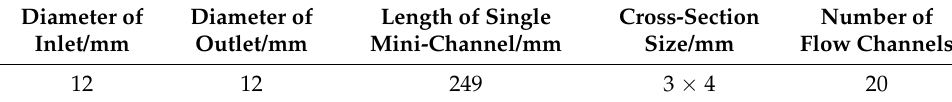
Table 1. Geometric parameters of the flow passageway.